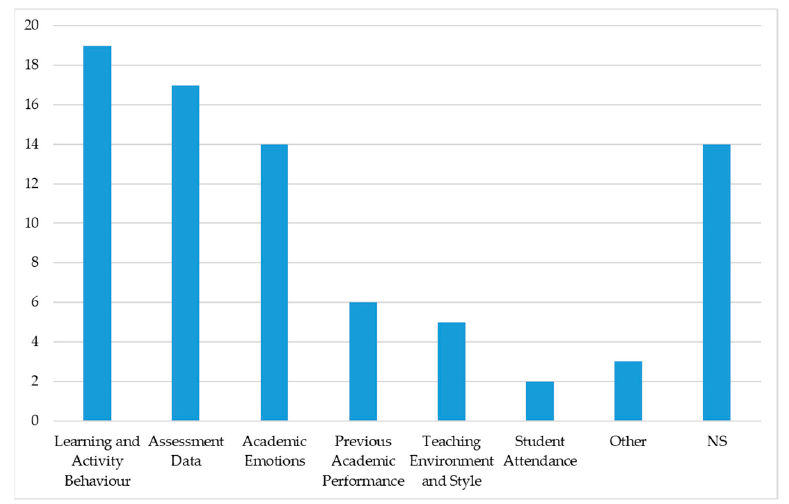
Figure 13. Dominant factors influencing the attainment of learning outcomes.; NS = not